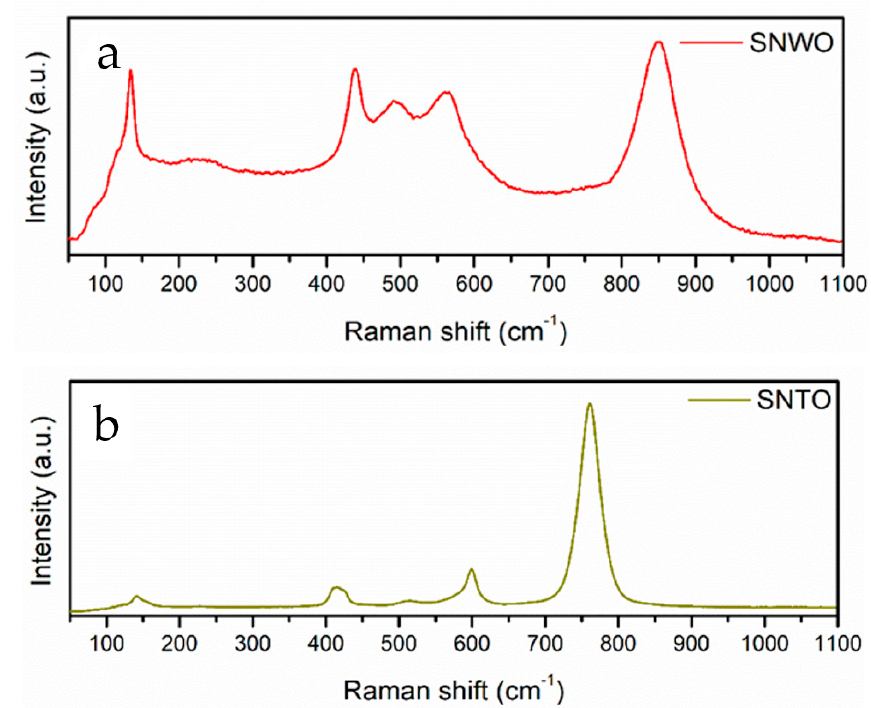
Figure 4. Raman spectra of the Sr 2 NiWO 6 (SNWO, ( a )) and the Sr 2 NiTeO 6 (SNTO, ( b )).